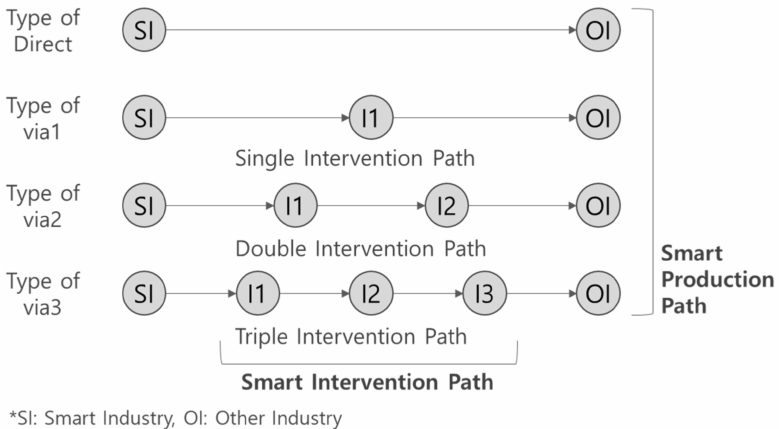
Figure 5. Concept of analysis for the smart production path and the smart intervention